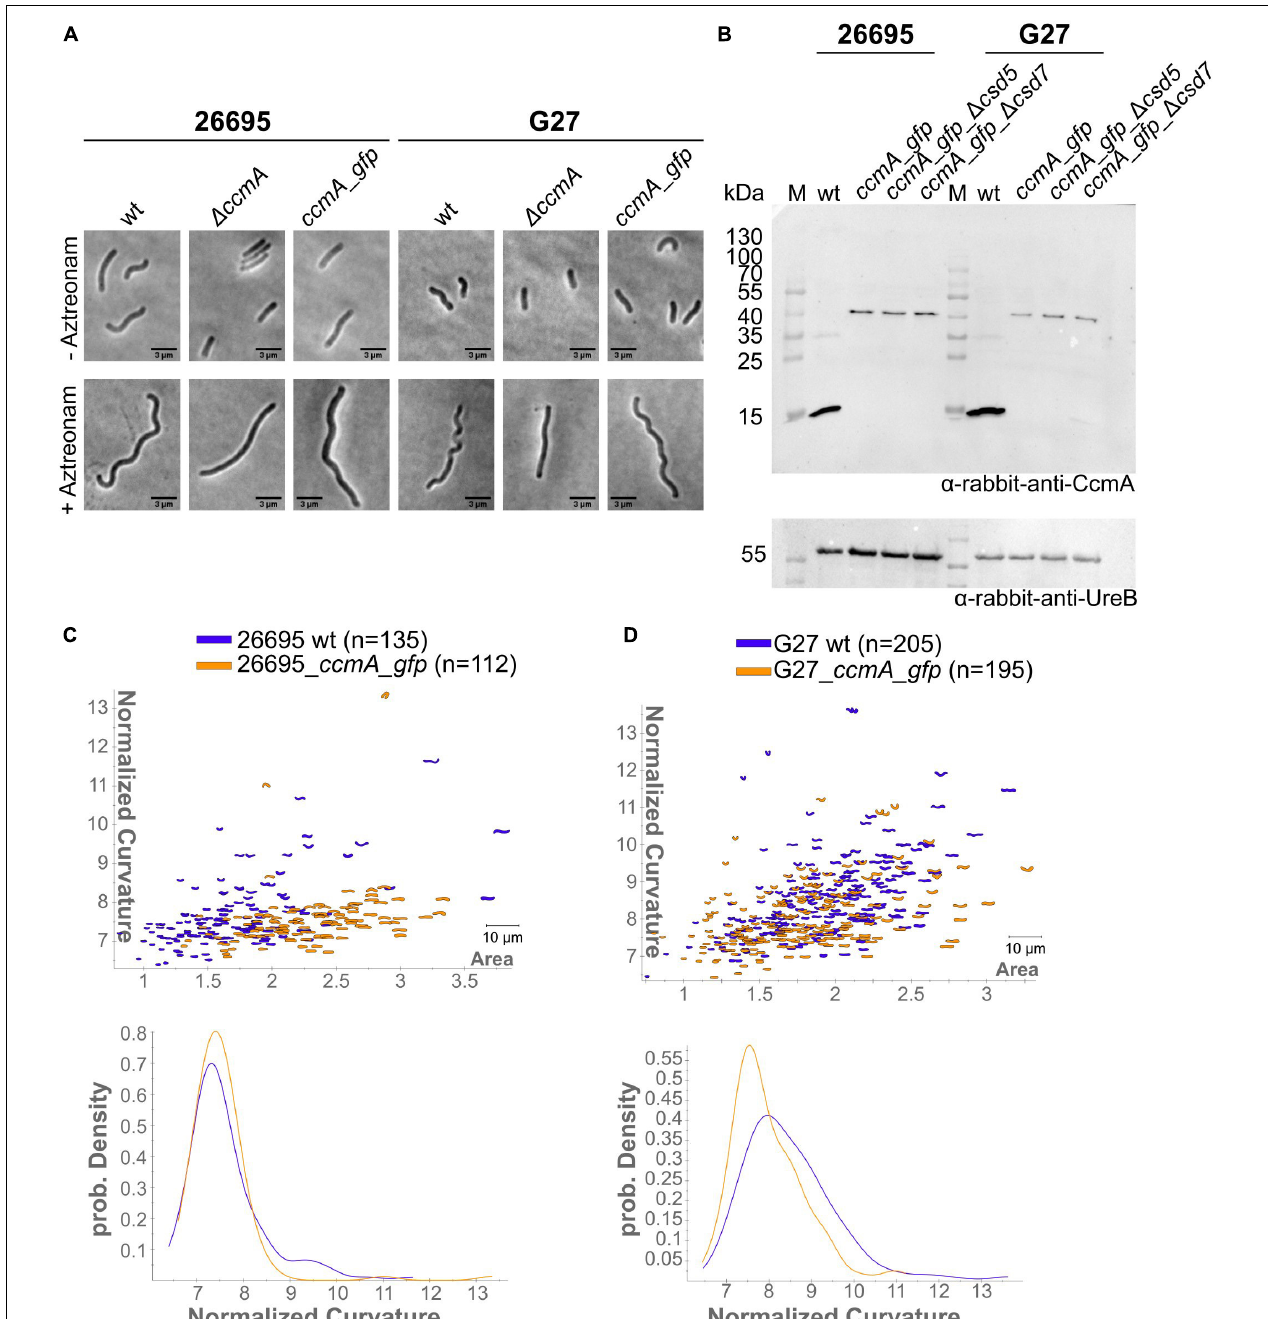
FIGURE 1 | (A) Exemplary phase-contrast images illustrating the effect of the insertion of ccmA_gfp at the native locus on the cell shape of H. pylori 26695 and G27. For a better comparison, filamentous growth was induced by treating cells with Aztreonam. CcmA_Gfp cells are slightly less curved as compared to the wt but clearly not as straight as the ccmA knockout. (B) Western blot of H. pylori strains was used in this study. The membrane was first probed with CcmA-specific antibodies. Afterward, the membrane was stripped and again probed with UreB-specific antibodies, serving as a loading control. (C) Comparison of 26695 wt and 26695_ ccmA_gfp by principal component analysis and probability density plot of normalized curvature. (D) Comparison of G27 wt and G27_ ccmA_gfp by principal component analysis and probability density plot of normalized curvature.